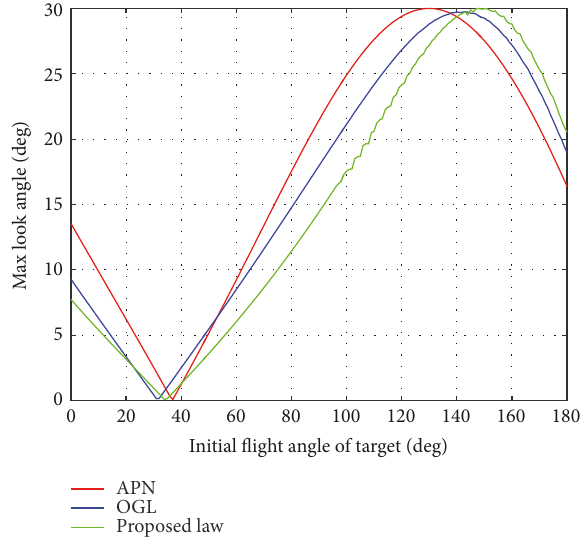
Figure 6: Max look angle of APN, OGL, and proposed law under different initial flight angel of target.